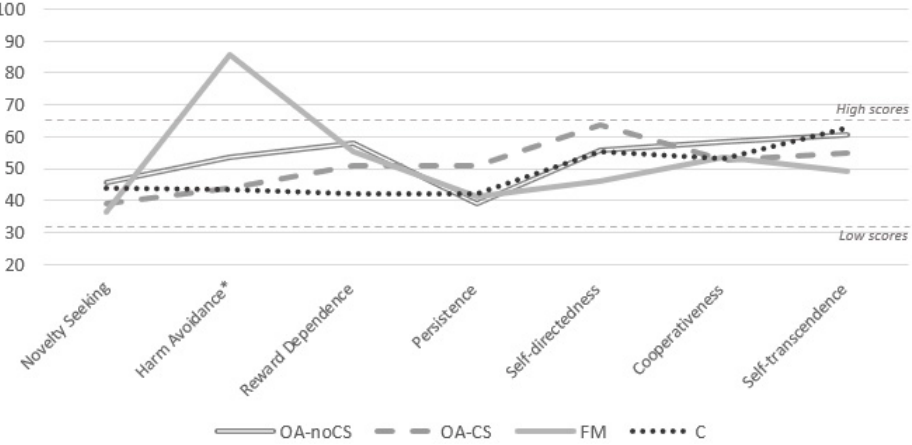
Figure 2. Group profiles of mean percentile scores of temperament and character dimensions of TCI-